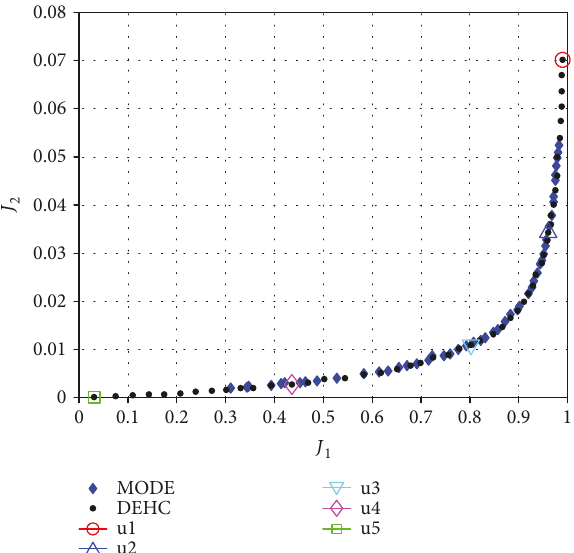
Figure 16: The Pareto optimal front for case